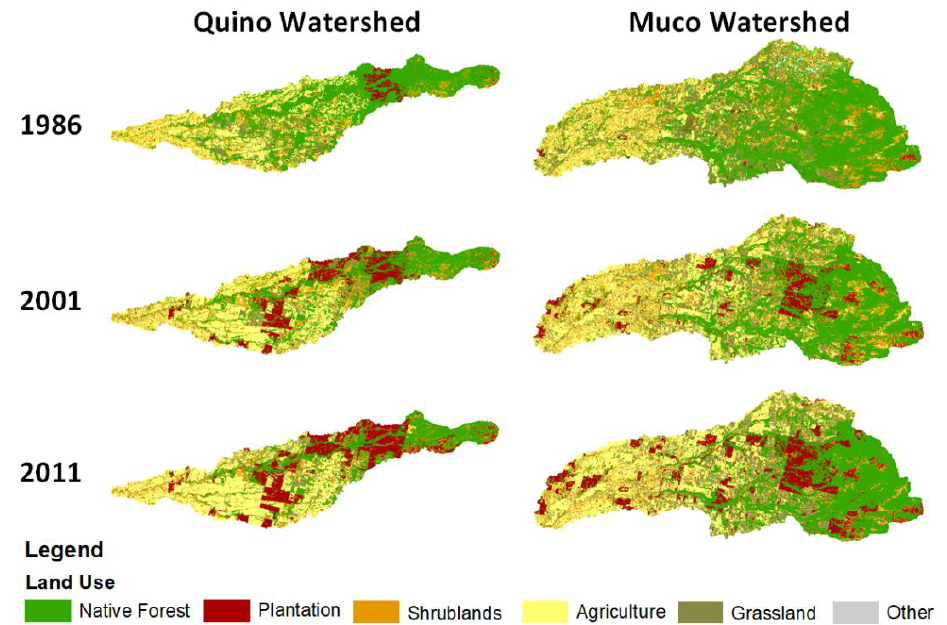
Figure 3. Spatial distribution of land use and covers (1986, 2001, and 2011).